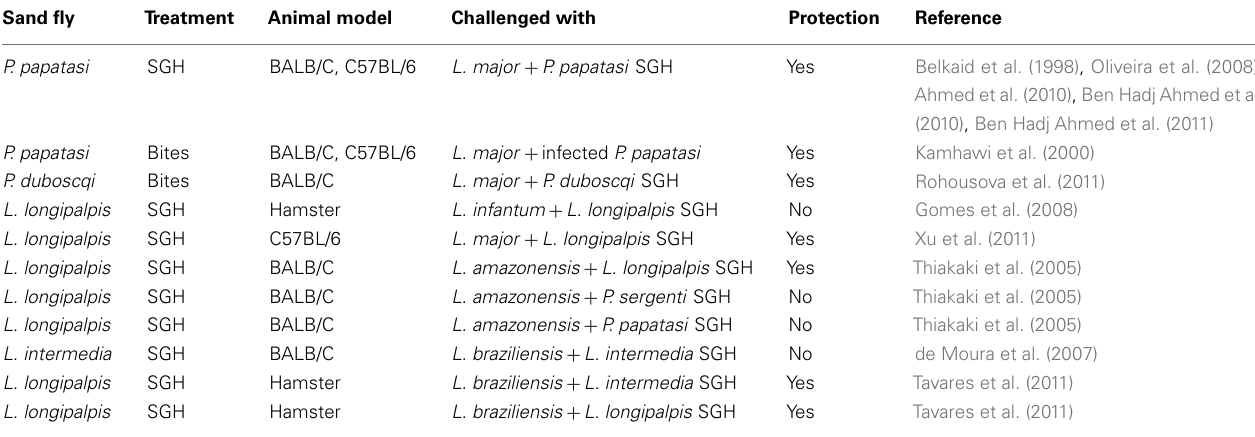
Table 1 | Protective potential of sand fly saliva against leishmaniasis. Sand